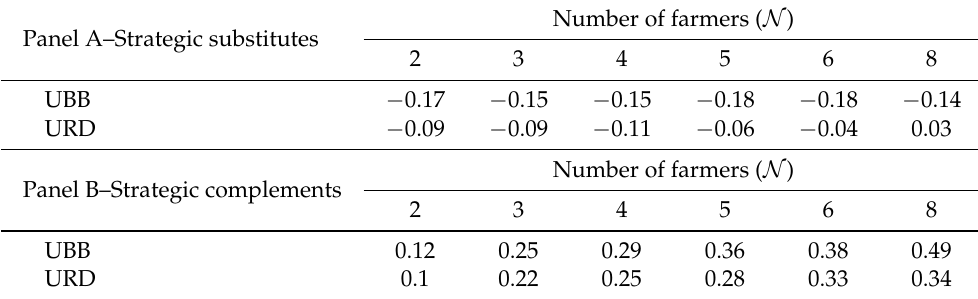
Table 3. Selten and Krischker’s (1983) [23] measure of predictive success of the GW program with (Panel A) strategic substitutes and (Panel B) strategic complements (sub-sample = 1000). Panel A–Strategic